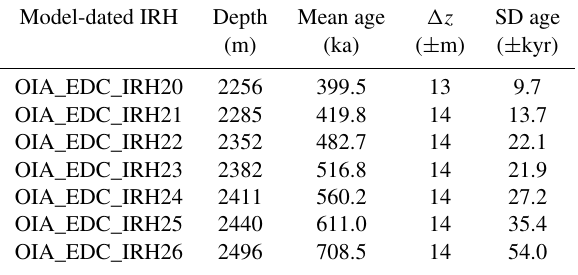
Table 4. Depths and modeled mean ages for the seven model- dated IRHs, using the Parrenin et al. (2017) 1D steady-state ice flow model. Depths are measured at the closest point along the DE- LORES radar transect HRB7-HRB8 to the final BELDC drill site (measured local ice thickness of ∼ 2747m), and depth uncertain- ties are calculated as described in Sect. 3.5 for that same location along transect HRB7-HRB8. Age uncertainties here are mostly rep- resentative of the model age uncertainty: they are calculated as the standard deviation of the spatial distribution of the age of each IRH.